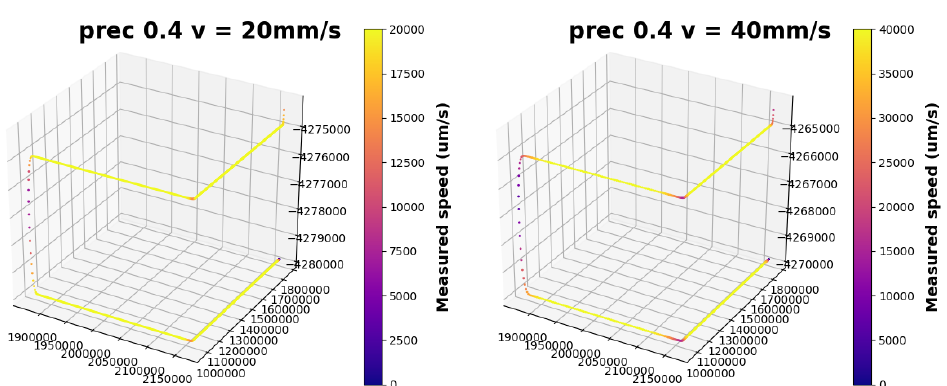
Figure 8. 3D plot of position as a function of velocity (precision e = 0.4) for two successive layers.